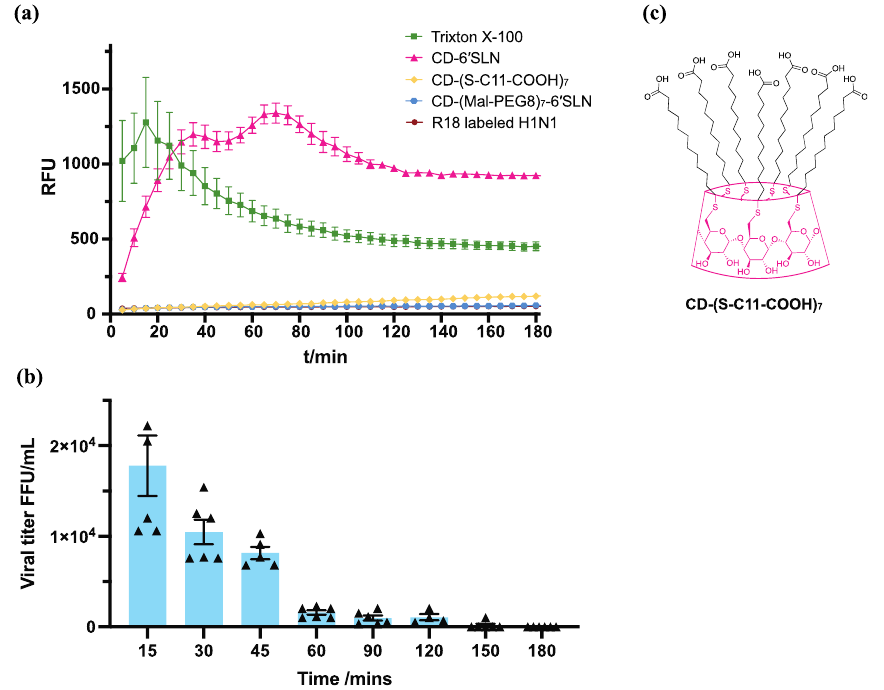
Figure 5. CD- 6’SLN interacts with the viral envelope. ( a ) Fluorescence intensity of R18-labeled H1N1 treated with 100 μg/mL CD - 6’SLN, 100 μg/mL CD -(S-C11-COOH) 7 , 100 μg/mL CD -(Mal- PEG8) 7 - 6’SLN or 1% triton X -100. ( b ) Infectious H1N1 titre of the virus-CD- 6’SLN mixture over time. Every triangle represents the viral titre determined in a single well. ( c ) Chemical structure of CD- (S-C11-COOH) 7 .